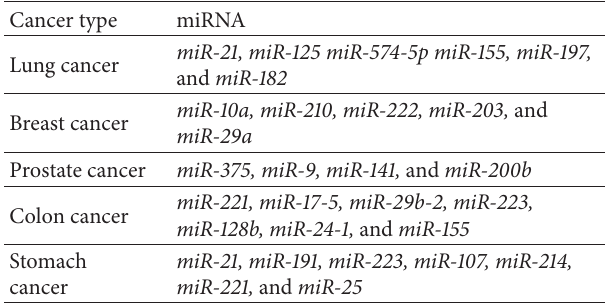
Table 1: List of miRNAs identified to influence clinical progression in specific cancer